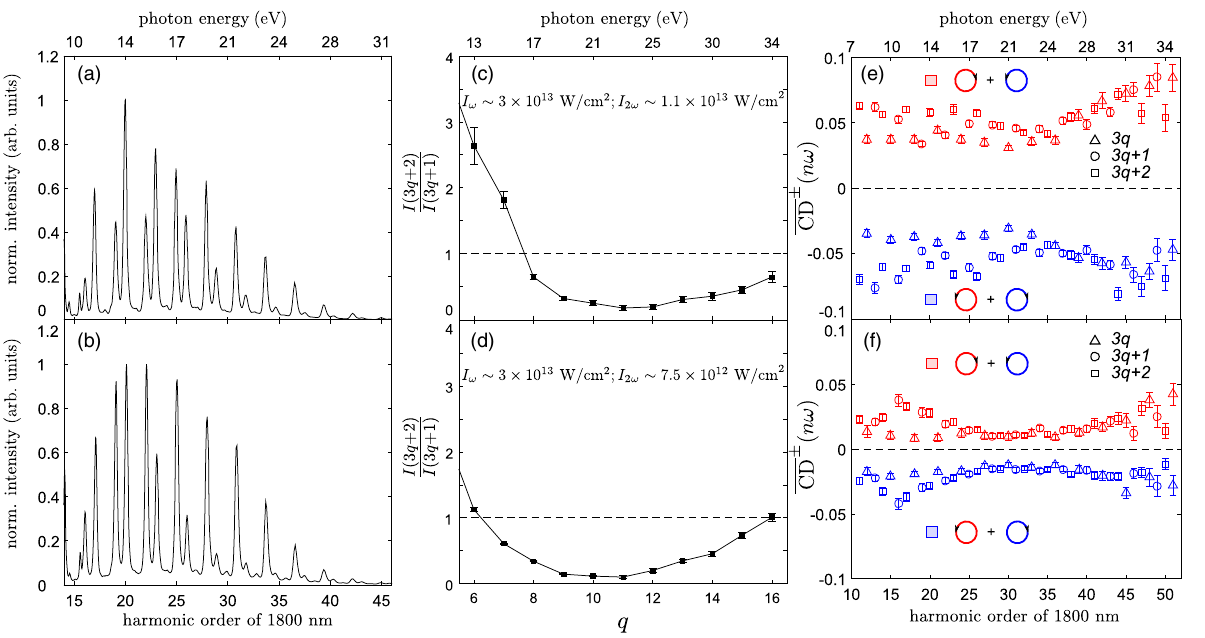
FIG. 3. Intensity dependence of CD. (a),(b) Angle-integrated [ α ∈ (cid:1)ð 20 ° − 55 ° Þ ] CD (cid:1) ð n ω Þ for bielliptical fields of opposite handedness ( þ or − , encoded as blue or red) as a function of the photon energy for two different intensities [cf. text insets in (c) and (d)]. (c),(d) Energy dependence of the ratio of two neighboring allowed harmonics [ I ð 3 q þ 2 Þ =I ð 3 q þ 1 Þ ] at α ¼ 45 ° for the measurements in (a) and (b). (e),(f) HHG spectra of R -MOX at the bicircular configuration (QWP angle α ¼ 45 °) recorded under the experimental conditions reported in (c) and (d), respectively. The error bars in (c) – (f) represent 2 standard deviations of the measured